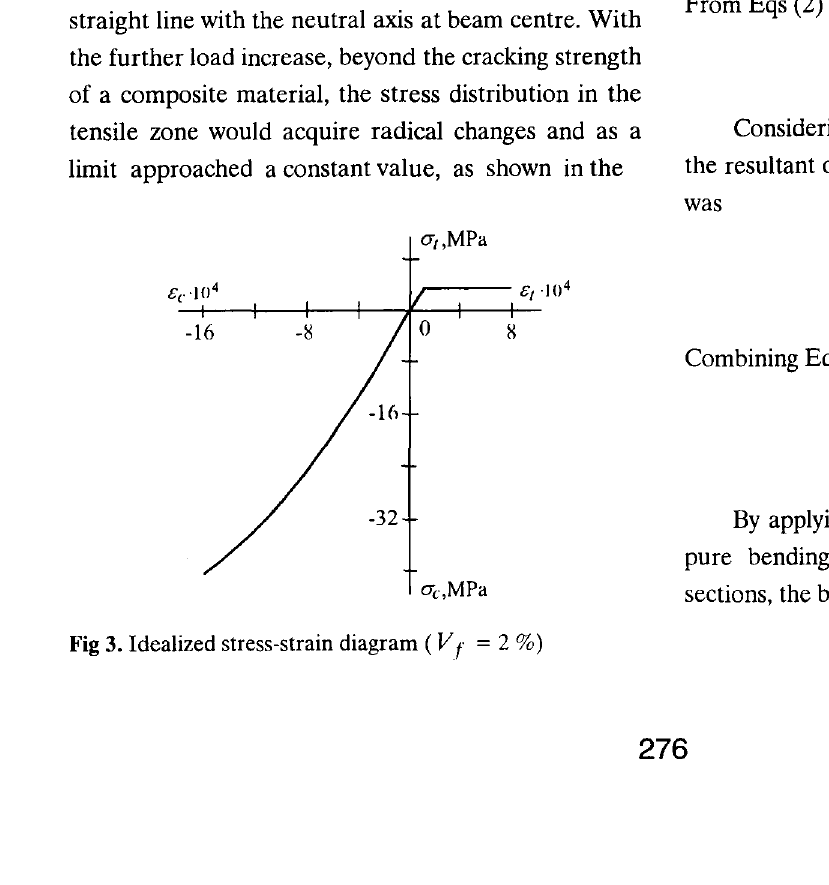
Fig 3. Idealized stress-strain diagram ( Vr = 2